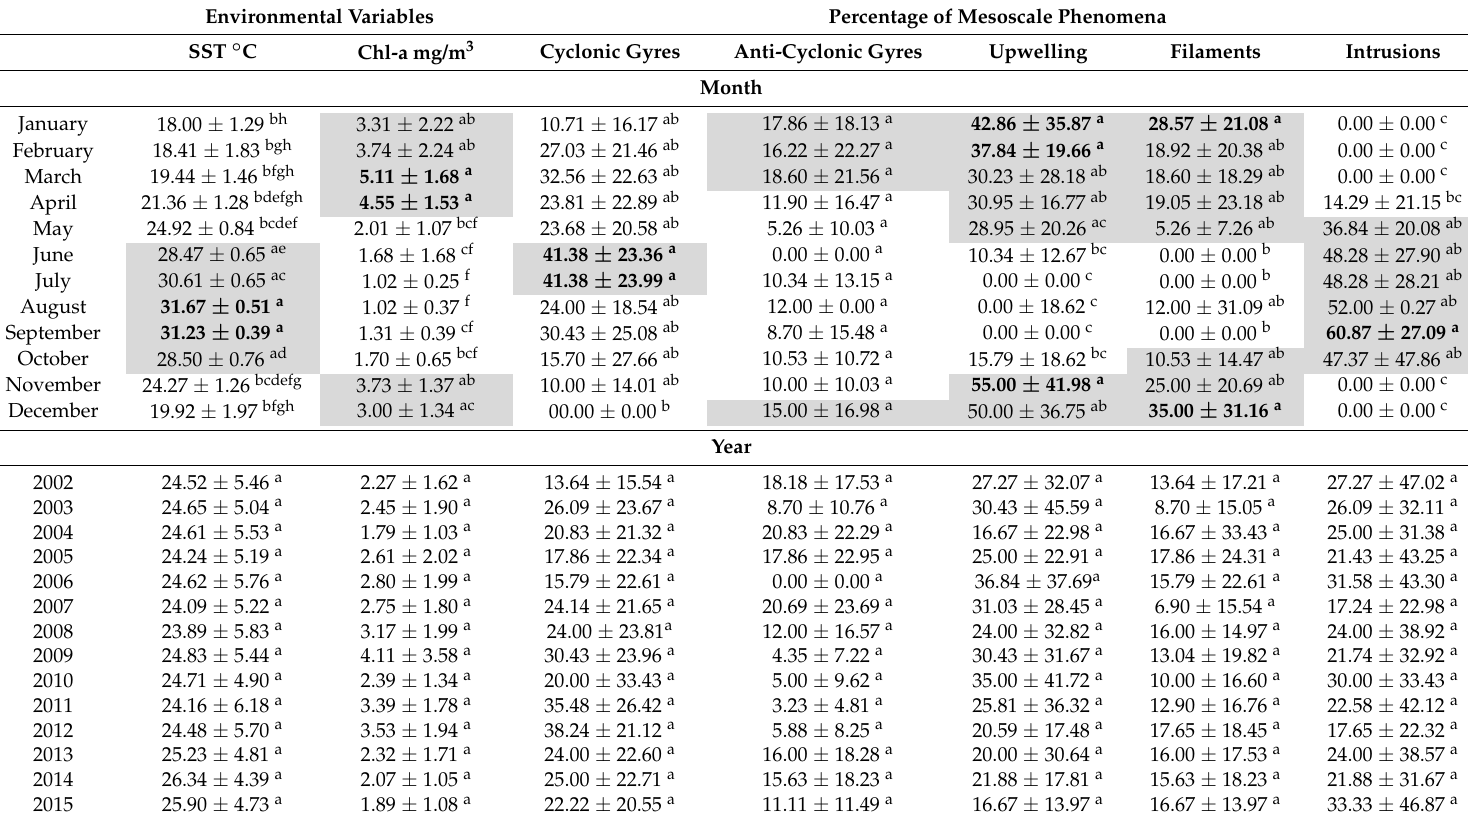
Table 2. Monthly and annual analysis of temperature, chlorophyll a and percentage of mesoscale phenomena observed in the central and southern coastal regions of Sonora and adjacent deep zone in the Gulf of California, Mexico, from